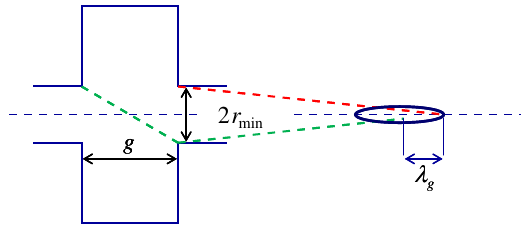
FIG. 3. Origin of (cid:2)